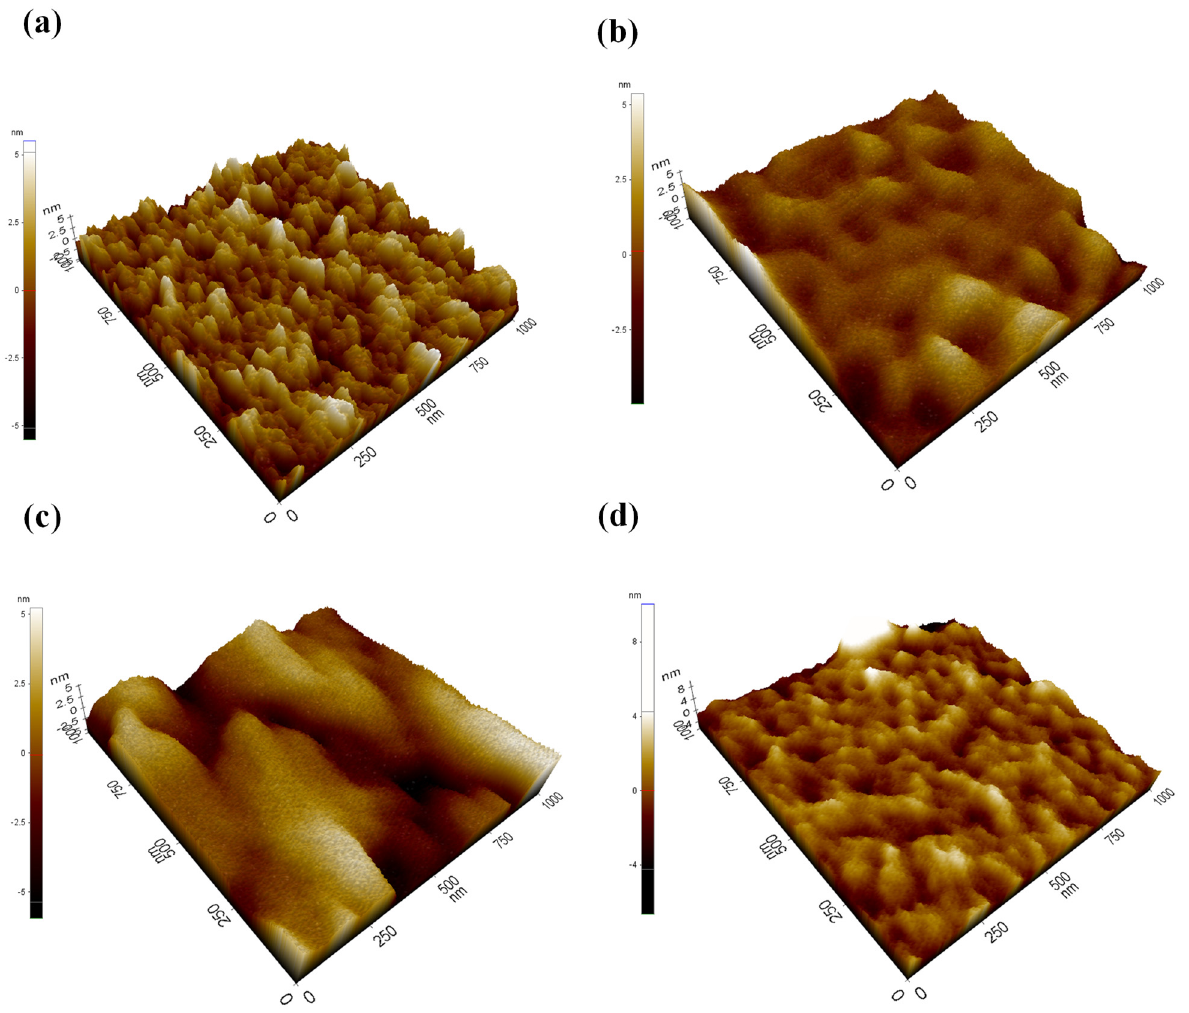
Figure 9. Three-dimensional AFM images of PEDOT: PSS without and with different organic additives and subjected to FA treatment: ( a ) PEDOT: PSS, ( b ) PEDOT: PSS-sorbitol (4 wt%), ( c ) PEDOT: PSS-maltitol (4 wt%), ( d ) PEDOT: PSS-sorbitol-maltitol (4 wt%; 3:1).